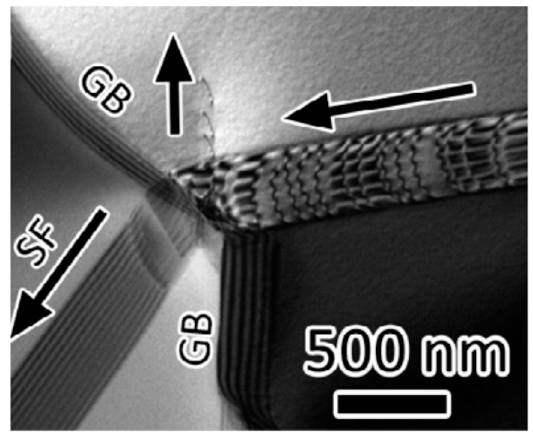
Figure 14. TEM image of twin formation induced by the dislocation–grain boundary interaction. (Reprinted from Reference [29], with permission from Elsevier).